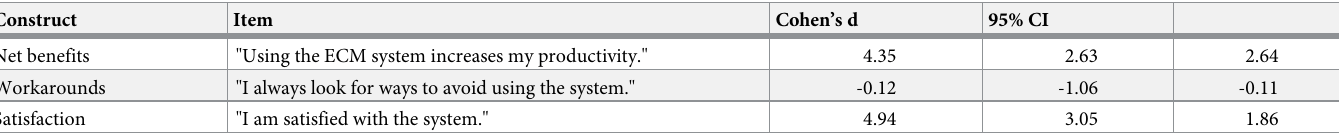
Table 5. Survey results of the effect size for user satisfaction of current method and the software. Construct Item Cohen’s d 95% CI Net